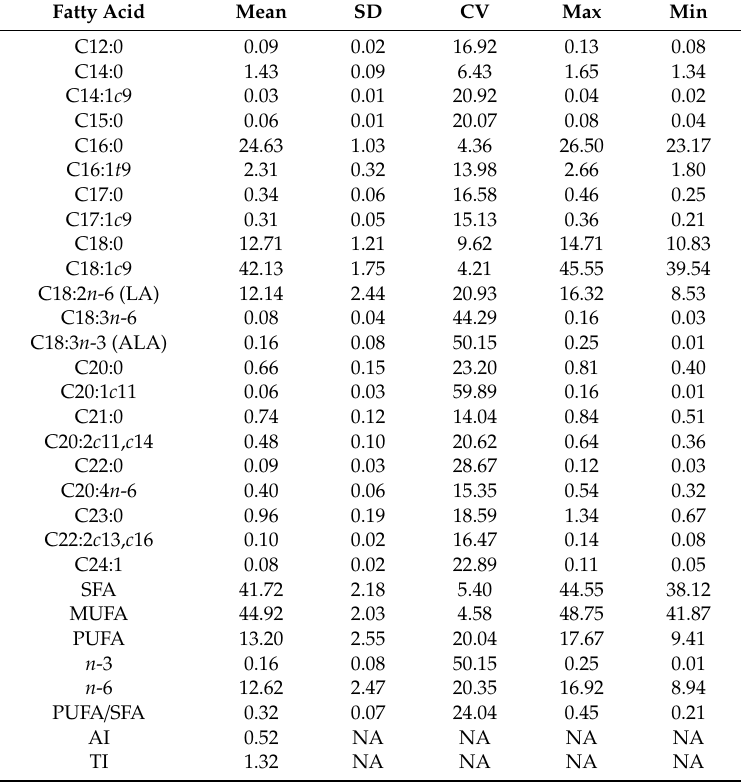
Table 4. Mean, standard deviation (SD), coe ffi cient of variation (CV) and maximum and minimum values of the fatty acid profile of chistorras in step